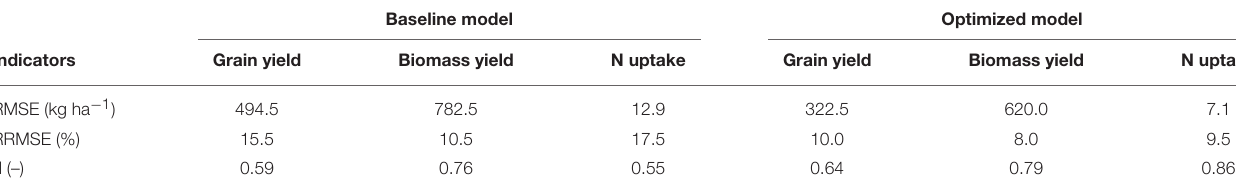
TABLE 3 | Statistical indicators showing the relationship between simulated and measured maize grain and biomass yield as affected by the combined application of 0 (NM) or 3 (3M) t ha − 1 of manure and two microdosing rates (MD1-MD2) over the 2 years (2014–2015).